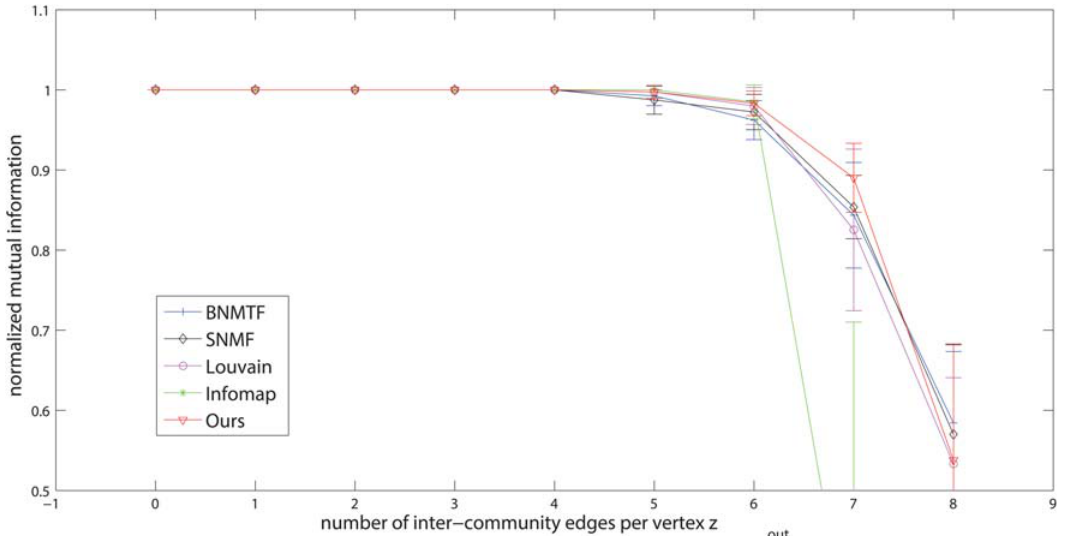
Fig 2. Evaluation of different methods on Newman ’ s benchmark networks in terms of NMI.